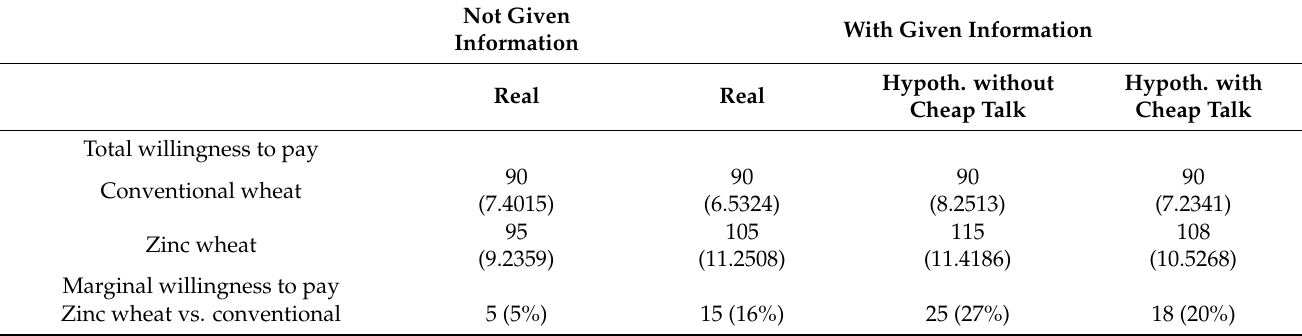
Table 5. Willingness to pay (WTP) and Marginal Willingness to pay (MWTP) for conventional and Zinc wheat based on the bivariate probit model. Not Given Information